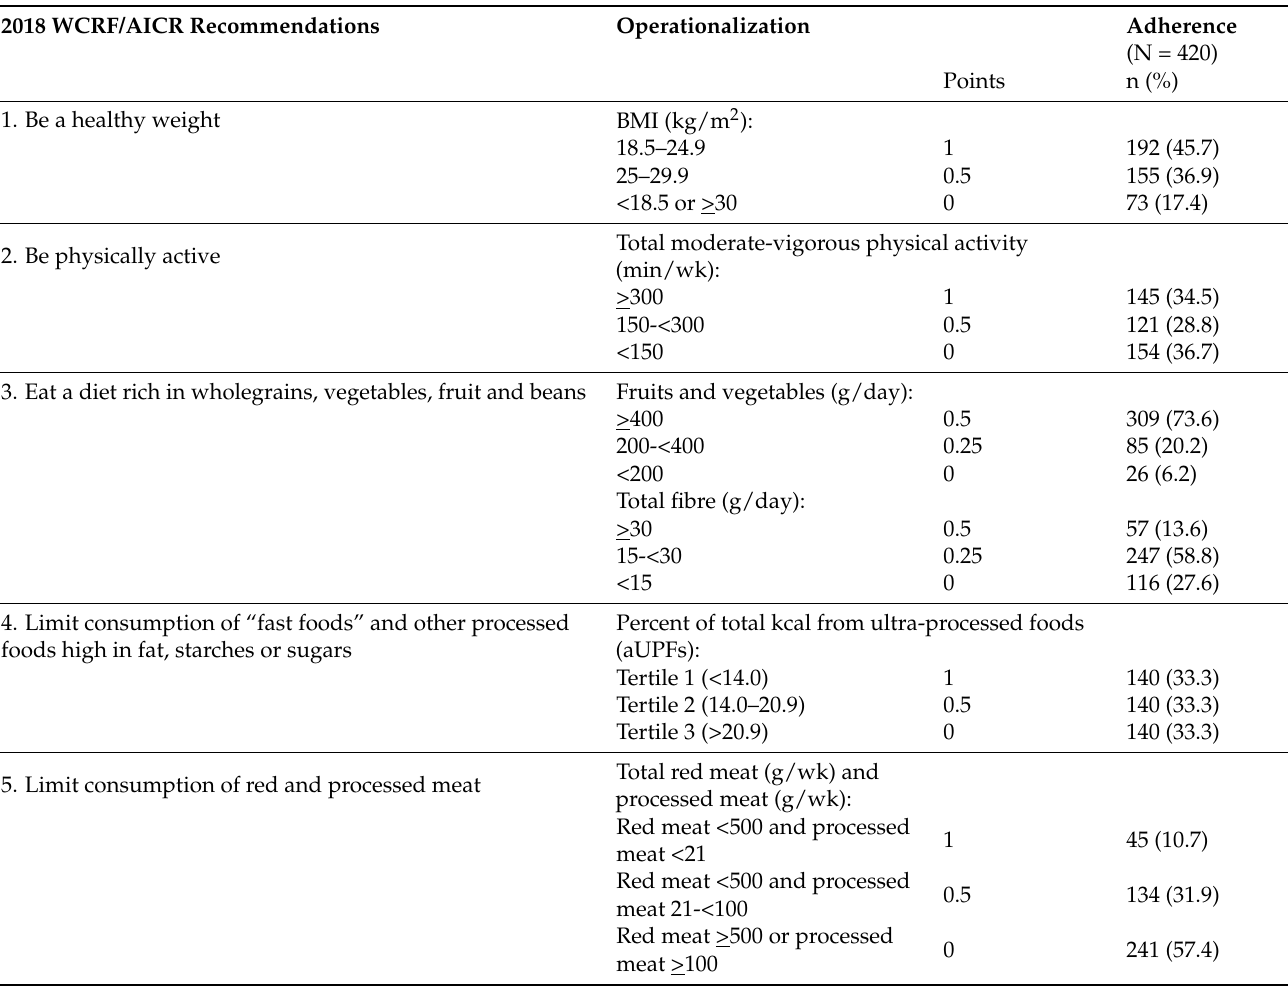
Table 1. Operationalizing, scoring and adherence to 2018 WCRF/AICR recommendations in breast cancer